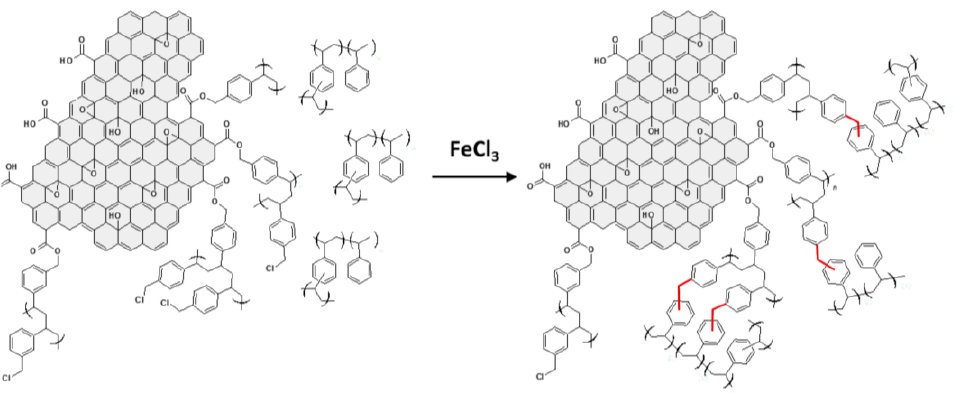
Figure 10. Schematic representation of the hyper-crosslinking reaction at the interface between PVBC-grafted GO and poly(DVB-ST). Crosslinking derived from the hyper-crosslinking reaction are evidenced in red. Reprinted with permission from [34]. Copyright 2017 American Chemical Society (Washington, United States of America).